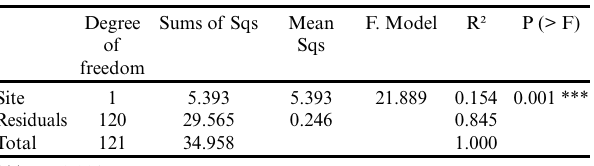
Table 2 . PERMANOVA results for the vegetation composition of sacred groves and surrounding woodlands.